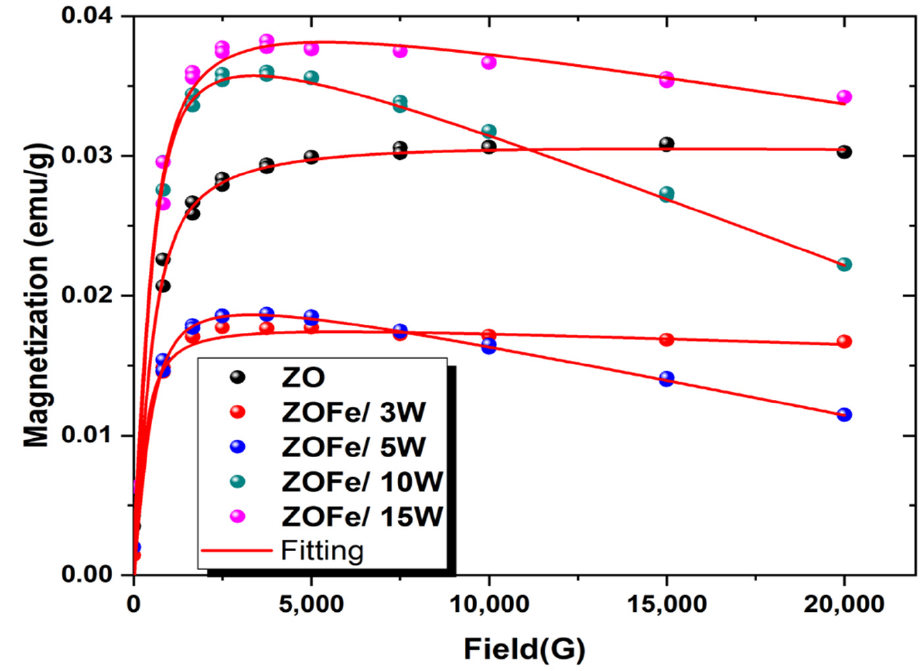
Figure 16. Fitting of the Langevin function with experimental M (H) curves.